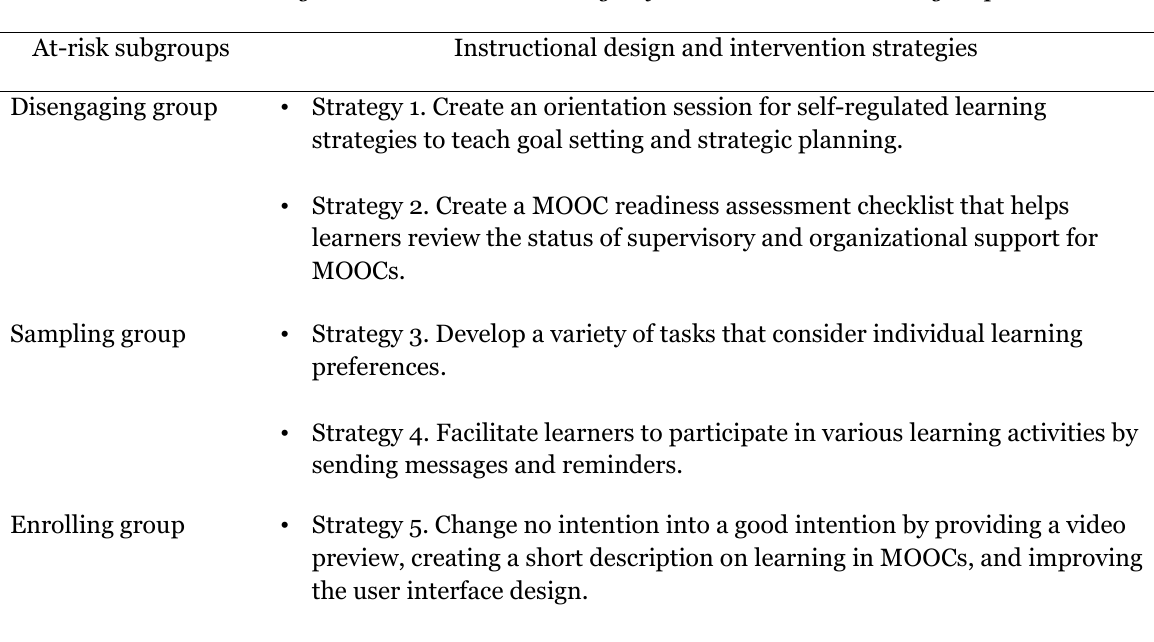
Table 5 Tailored Instructional Design and Intervention Strategies for the Three At-Risk Subgroups At-risk subgroups Instructional design and intervention strategies Disengaging